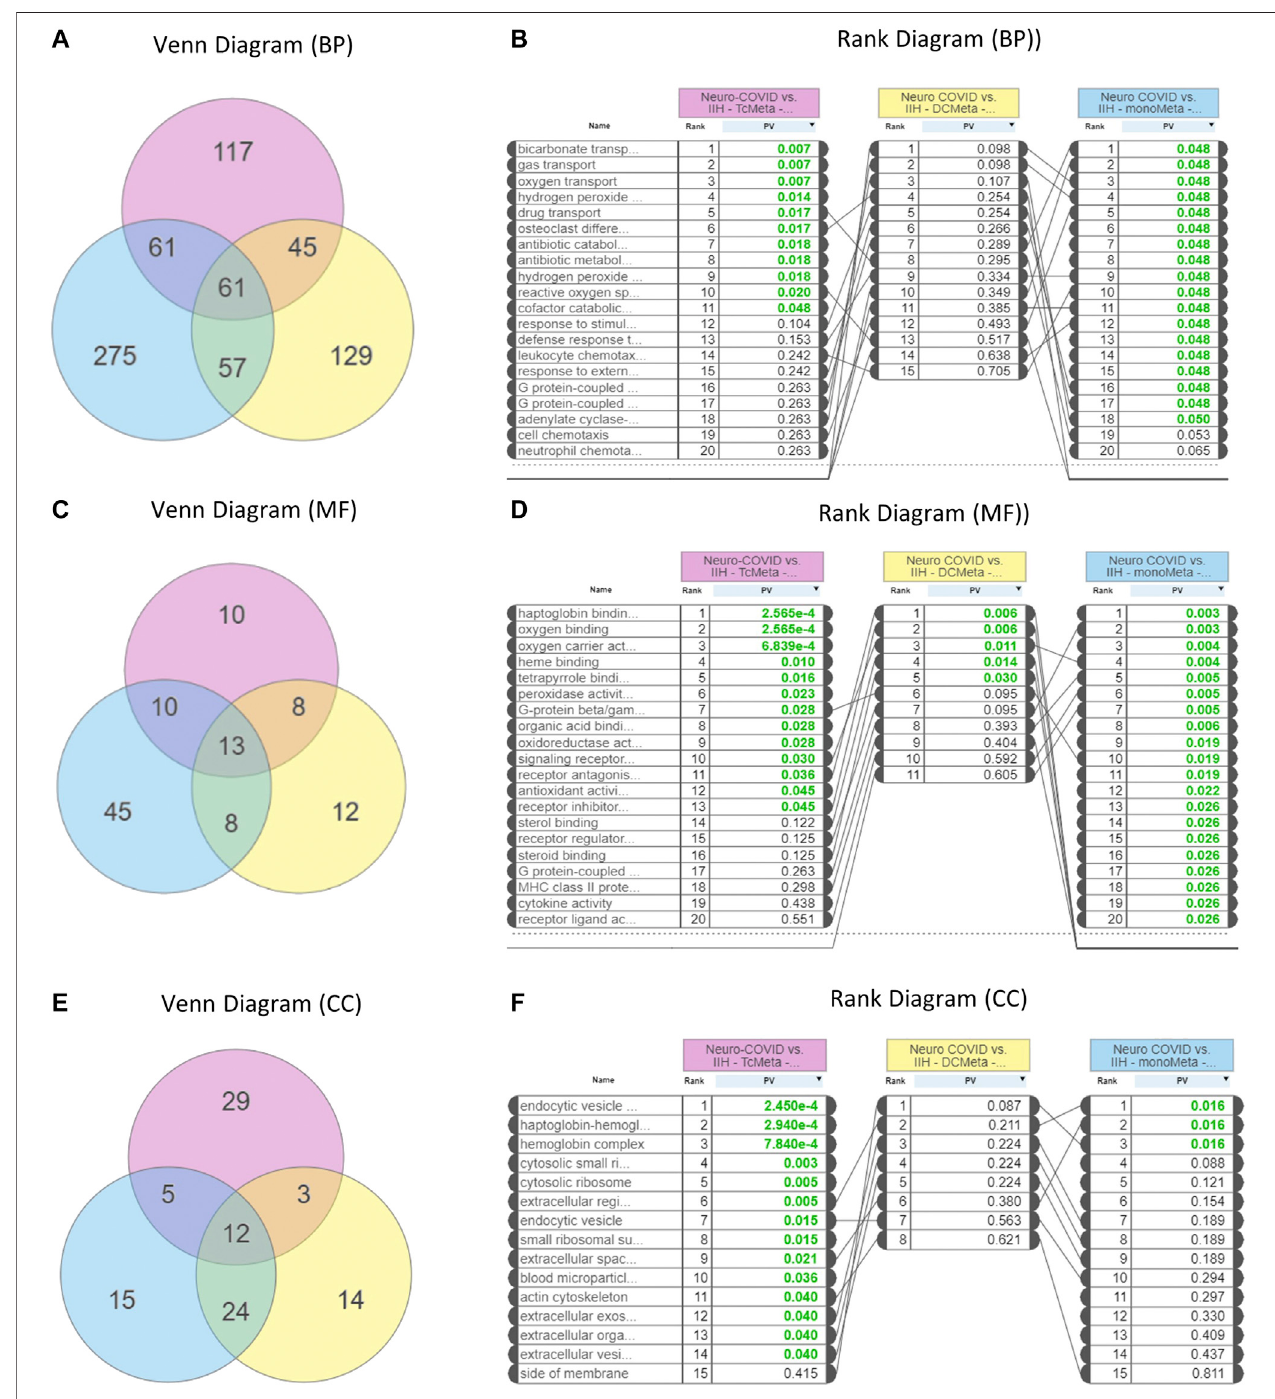
FIGURE 3 | Enrichmentofgeneontologies(GO)suchasbiologicalprocess(BP),molecularfunction(MF),andcellularcomponent(CC)inNeuro-COVIDvs.IIHcomparison basedoniPathwayGuideanalysis. (A) Vennand (B) rankdiagramsshowtheBPenrichedbetweenTcMeta,DCMeta,andmonoMeta. (C) Vennand (D) rankdiagramsshow the MF enriched between TcMeta, DCMeta, and monoMeta. (E) Venn and (F) rank diagrams show the CC enriched between TcMeta, DCMeta, and monoMeta.